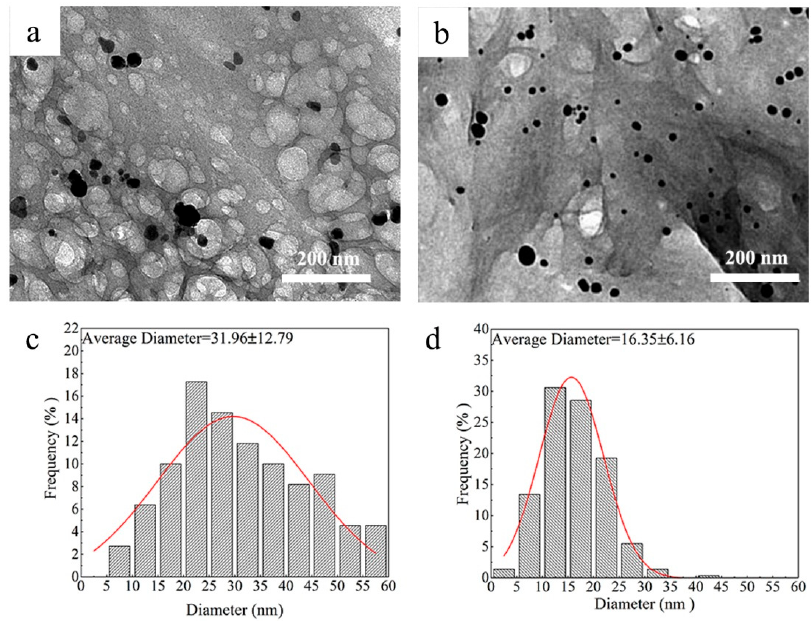
Figure 3. TEM images and size diameter distribution of AgNPs stabilized on ( a,c ) CCNC and ( b,d ) CSos-CCNC.